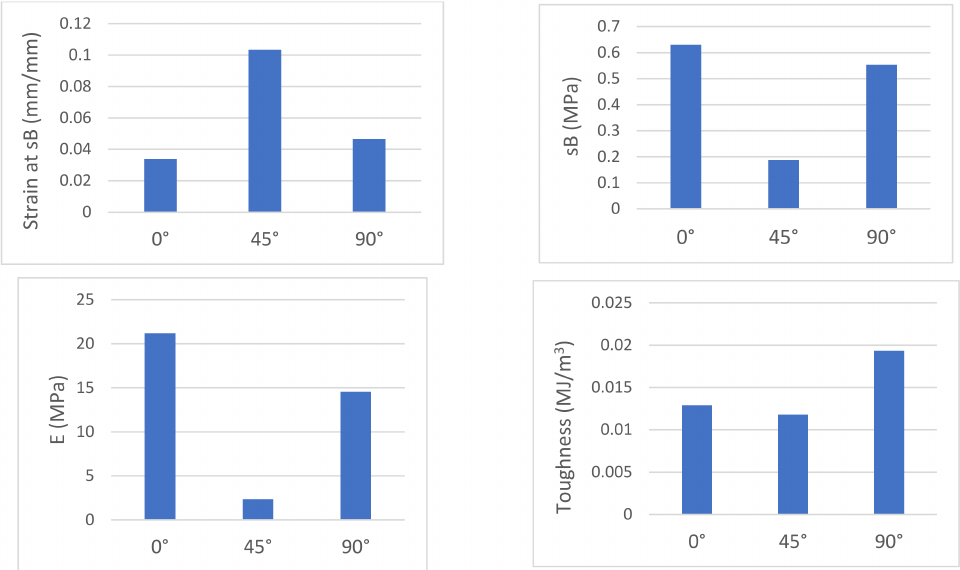
Figure 22. Strain at sB, Modulus of Elasticity, sB value and toughness of lattice structure #2 for different cell mapping